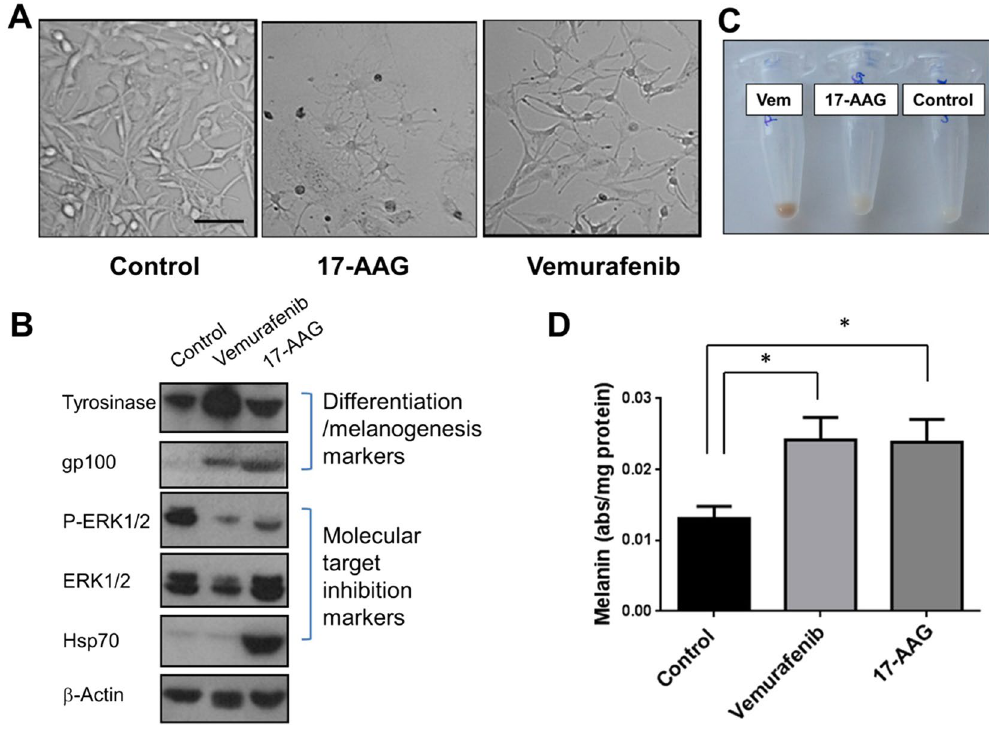
Figure 2. Hsp90 and BRAF inhibition leads to human melanoma cell differentiation and induction of melanin synthesis. ( A ) Bright field images showing the increased dendritic morphology in SKMEL28 melanoma cells following inhibition with vemurafenib (1 μ M) or 17-AAG (50 nM) for 72 h (scale bar: 100 μ m). ( B ) Western blots confirm the induction of melanoma cell differentiation (increased gp100) and melanogenesis (increased tyrosinase) concomitant with the expected molecular signature of BRAF and Hsp90 inhibition following exposure to vemurafenib (Vem) and 17-AAG for 72 h. ( C ) Images of SKMEL28 pellets showing increased pigmentation following exposure to vemurafenib or 17-AAG for 72 h. The different tubes contain the same number of cells. ( D ) Spectrophotometric absorbance measurements in SKMEL28 cells confirm induction of melanin synthesis following treatment with the BRAF inhibitor vemurafenib and the Hsp90 inhibitor